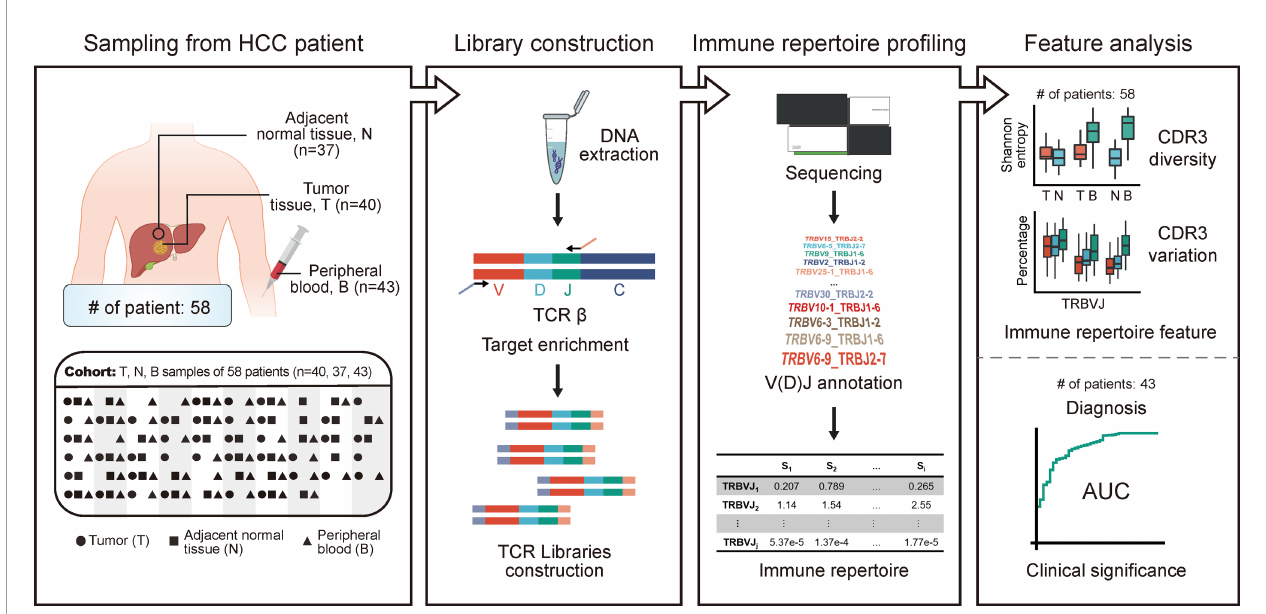
FIGURE 1 | The design and fl owchart of this study. HCC cohort: 40 tumors, 37 adjacent non-tumor tissues, and 43 peripheral blood samples were collected from 58 patients diagnosed with HCC. The TCR repertoire of patients was pro fi led using high-throughput TCR sequencing. The abundance and diversity of TCR were characterized based on HCC cohort, while the clinical signi fi cance of circulating TCR repertoire for diagnosis and prognosis was explored based on peripheral blood samples from HCC cohort. HCC, hepatocellular carcinoma; TCR, T-cell